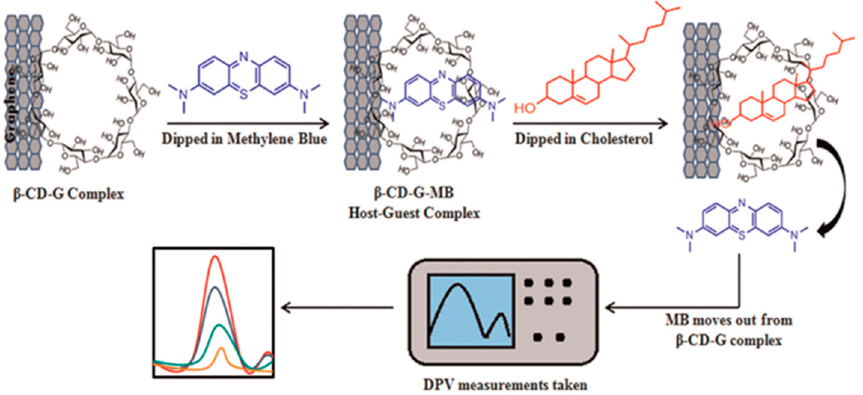
Figure 11. Demonstration of cholesterol sensing, using Grp- β -CD as the working electrode. Reprinted with permission from Ref. [78].